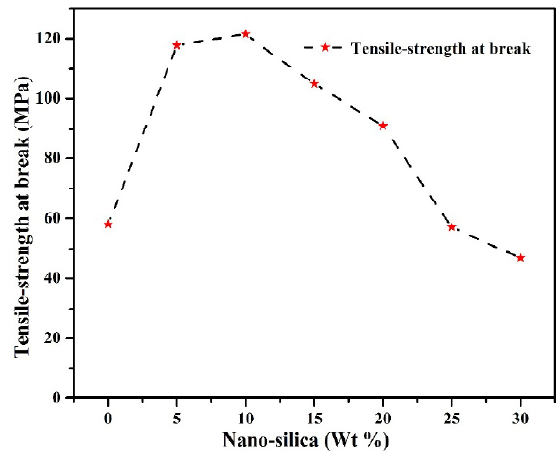
Fig. 9. Tensile-strength of PA/SiO